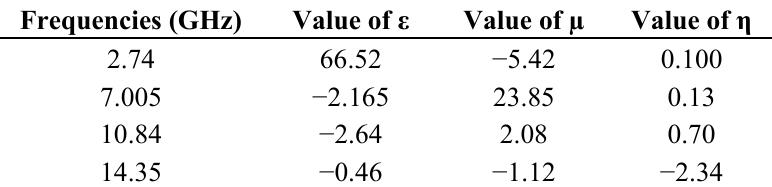
Table 6. Real values of ε, µ and η in the desired resonance frequency bands for the 2 × 2 unit